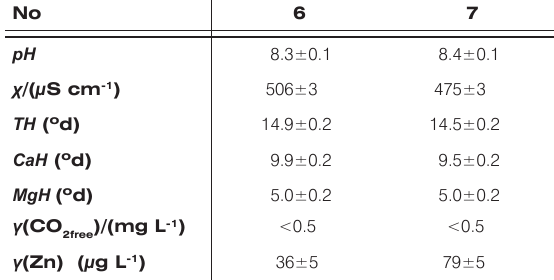
Table 3. Physico-chemical analyses of boiled treated samples taken from Maribor